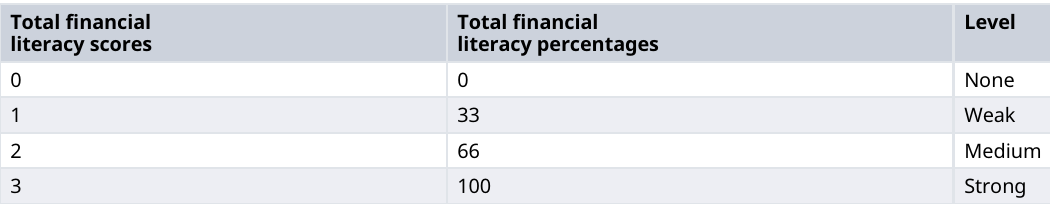
Table 1. Benchmarking scores and levels of financial literacy.